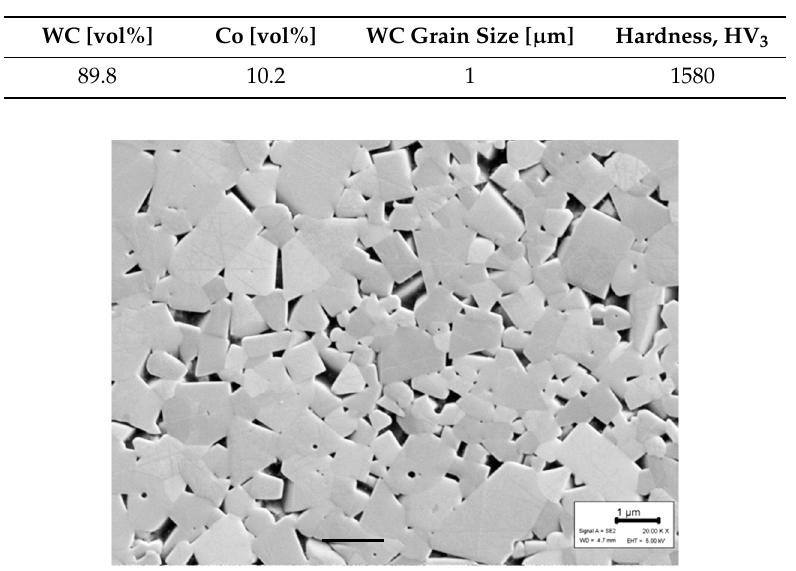
Table 1. Chemical composition (in weight %) and hardness of the work-piece material Ti6Al4V according to the material specification provided by material supplier Timet.